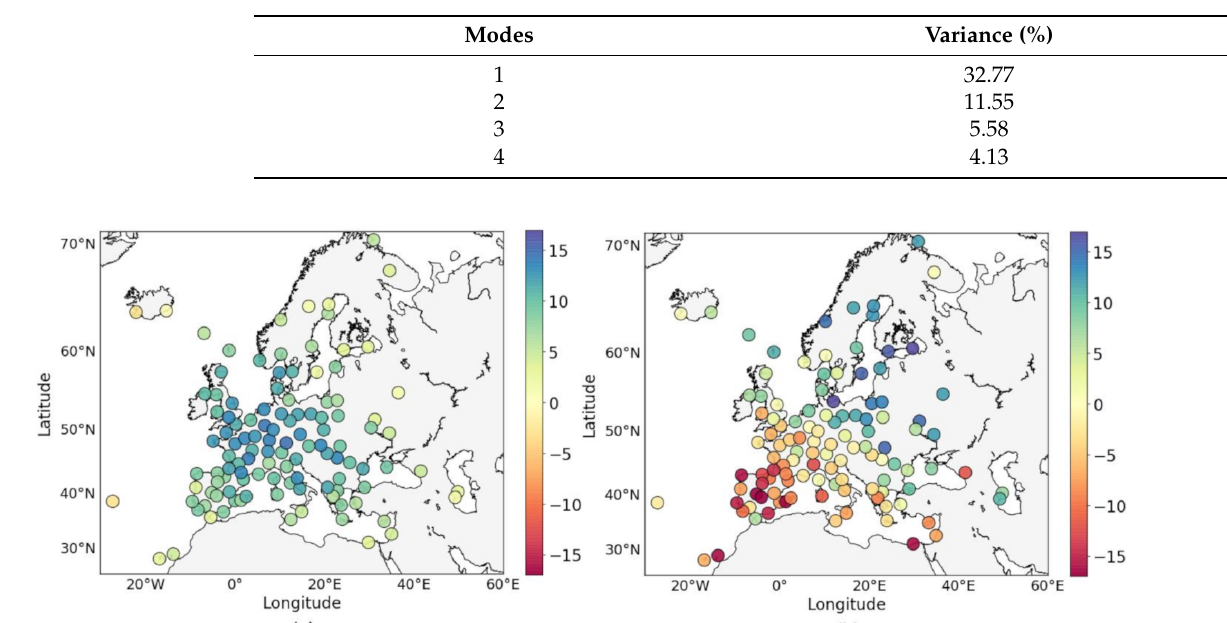
Table 1. Percentage of variance explained by the first four modes of variability of the GPS Up coordinate residuals.